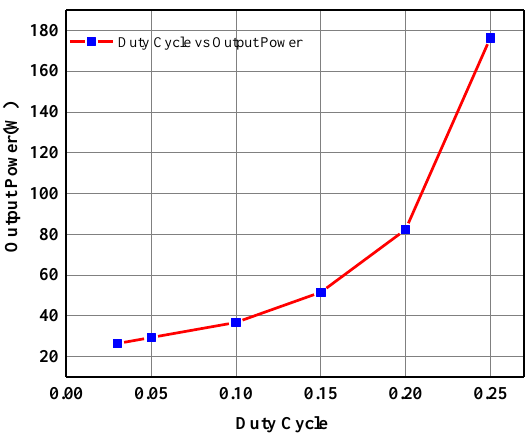
Figure 20. Variation of the output power at different duty cycles.